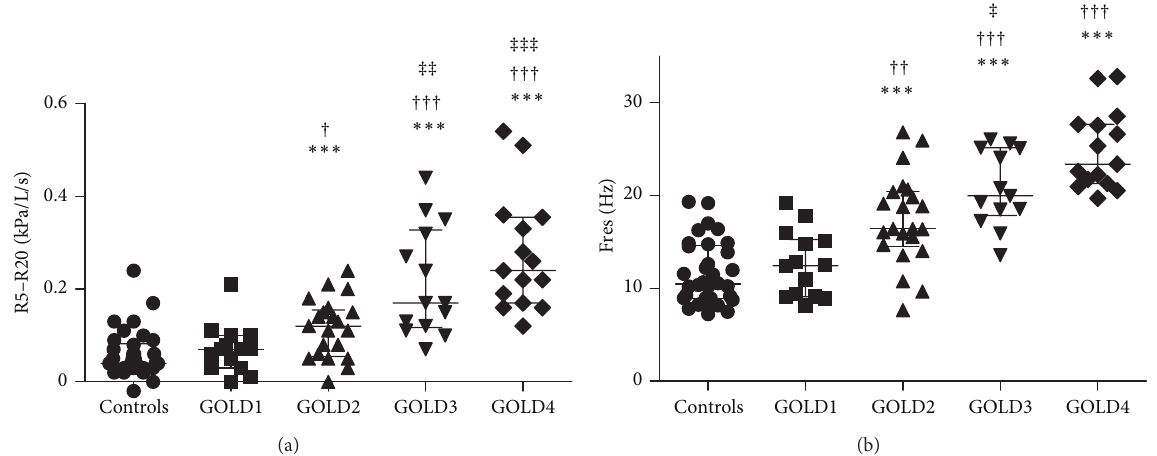
Figure 4: R5–R20 (a) and Fres (b) measured by impulse oscillometry in controls (healthy smokers) and COPD patients with GOLD stage 1–4. ∗ significant difference compared to healthy smokers, † significant difference compared to GOLD1, ‡ significant difference compared to GOLD2, # significant difference compared to GOLD3, one symbol flagging 𝑃 < 0.05 , two symbols flagging 𝑃 < 0.01 and three symbols flagging 𝑃 < 0.001 . Data presented as individual dots together with median with interquartile